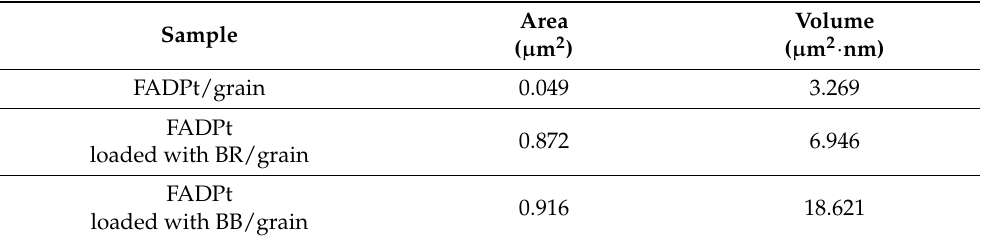
Figure 4. AFM topography, average roughness and pore distribution before and after adsorption/photocatalysis for: ( a ) FADPt; ( b ) FADPt loaded with BR; ( c ) FADPt loaded with BB. Table 3. The parameters of grains analyzed based on AFM images. Table 3. The parameters of grains analyzed based on AFM images.